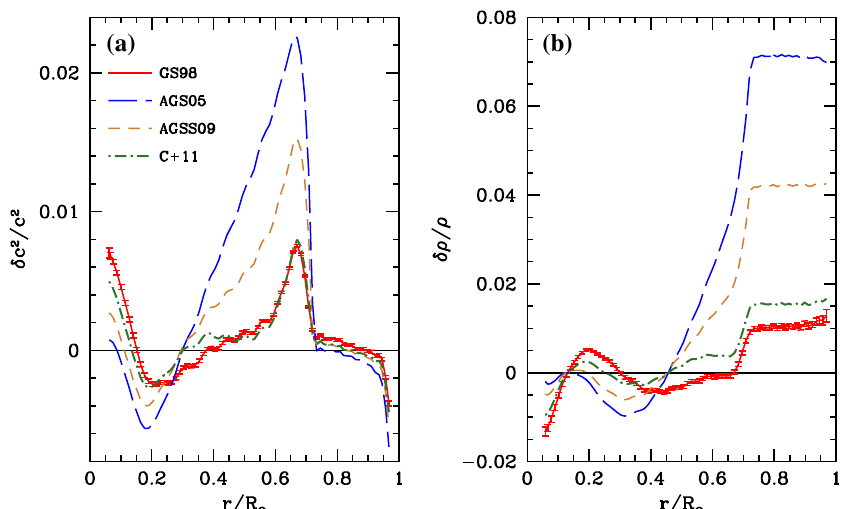
Fig. 23 The relative sound-speed and density differences between the Sun and four standard models constructed with different heavy-element abundances but otherwise identical physics inputs. The model GS98 was constructed with Grevesse and Sauval (1998) abundances, AGS05 with Asplund et al. (2005a) abundances,AGSS09withAsplundetal.(2009)abundances,andmodelsC+11wasconstructedwithCaffau et al. (2010, 2011) abundances supplemented with abundances from Lodders (2010)